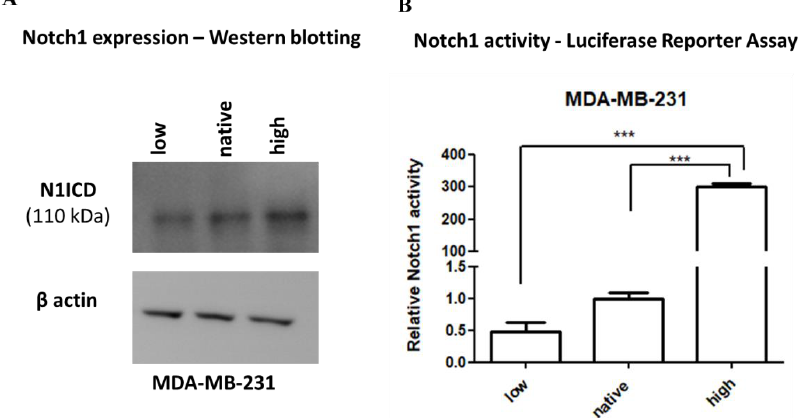
Figure 2. Immunoblotting and Luciferase Reporter Assay of Notch1 high (N1ICD), Notch1 low (dnCSL), or native MDA-MB-231 breast cancer cells. ( A ) MDA-MB-231 breast cancer cells transfected with ∆ EN1ICD or dnCSL show that ∆ EN1ICD increases the levels of N1ICD protein, while no changes were detected in dnCSL as compared to native MDA-MB-231 cells. Anti- β -actin antibody was used as a control for equal loading. Representative blots from tree-independent experiments are shown; ( B ) Notch signaling activity from the 12xCSL-luc reporter in MDA-MB-231, Notch1 low MDA-MB-231, and Notch1 high MDA-MB-231 breast cancer cells. The relative activity of Notch1 was normalized to the activity of native MDA-MB-231 cells. The results are presented as mean ± standard error of mean ( ± S.E.M). Statistical analysis was